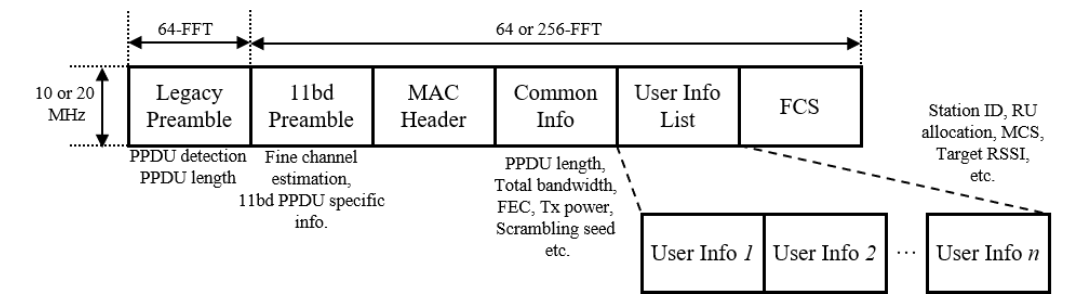
Figure 1. Trigger frame